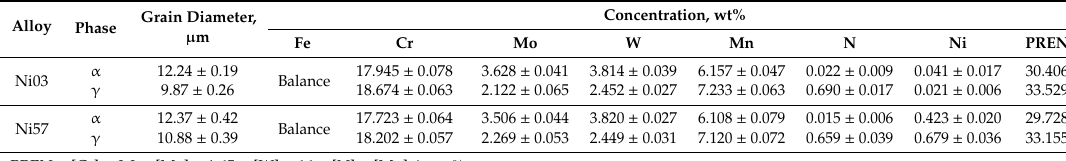
Figure 3. EBSD image quality maps of ( a-1 ) Ni03 and ( b-1 ) Ni57 alloys and phase maps of ( a-2 ) Ni03 and ( b-2 ) Ni57 alloys (green—face-centered cubic ( γ ) and blue—body centered cubic ( α )). ( c ) Grain diameters of the α and γ phases in the Ni03 and Ni57 alloys. Table 2. Chemical compositions (in wt %) of the α and γ phases of the Ni03 and Ni57 alloys measured using an EPMA.